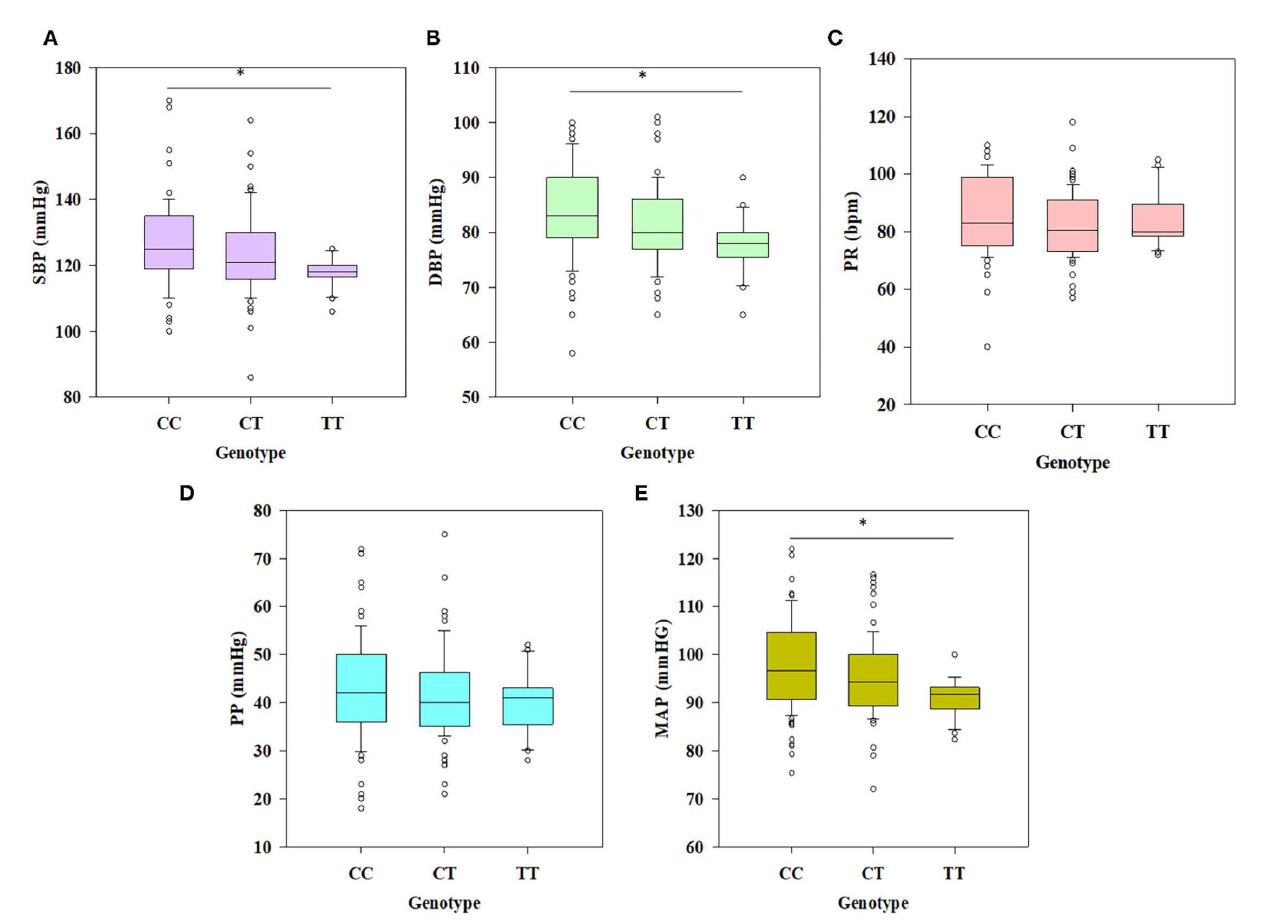
FIGURE3 Box plots deciphering the results of ANOVA among different genotypes (CC, CT, and TT) for physiometric traits. (A, B, E) Significant differences were observed between genotypes CC and TT with SBP ( p = 0.001), DBP ( p = 0.001), and MAP ( p = 0.001); (C, D) non-significant differences were observed for PR ( p = 0.087) and PP ( p = 0.402), respectively ( * p <